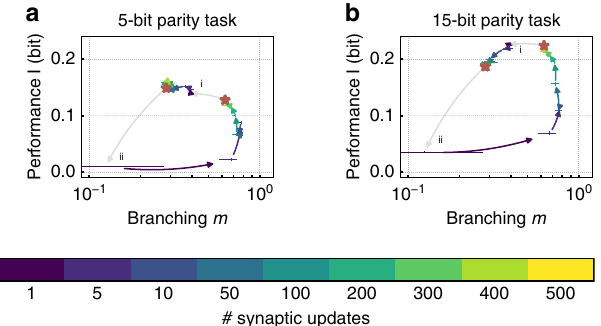
Fig. 6 The network can be dynamically adapted by changing the degree of the input K ext . After convergence of synaptic weights w ij , K ext / N is (i) switched from critical ( K ext = 0.3) to subcritical ( K ex = 0.8) and (ii) vice versa. The branching ratio m and the performance I of the network on a the 5-bit and b the 15-bit parity task are evaluated after various numbers of synaptic updates. The network reaches the same performance and dynamics as when starting from w ij = 0 ∀ i , j (marked by red stars). For both tasks, the transition from subcritical to critical dynamics requires more updates as expected. Moreover, optimal performance for ( a ) the 5-bit task is achieved under strong input (i), whereas ( b ) the 15-bit task requires low input (ii). The performance is quanti fi ed by the mutual information I between the parity of the input and the vote of a linear classi fi er.